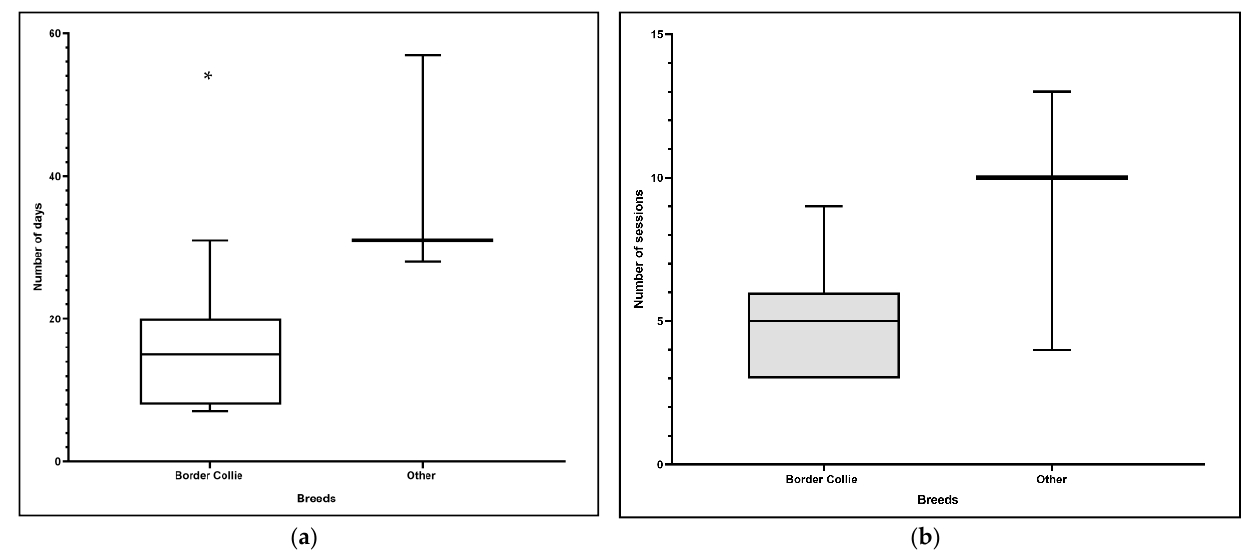
Figure 3. ( a ) Comparison of border collies and other breeds for number of days until lameness recovery ( p = 0.04); * this is the only variable with a statistically significant difference. ( b ) Comparison of border collies and other breeds for number of therapy sessions until lameness recovery ( p = 0.24).